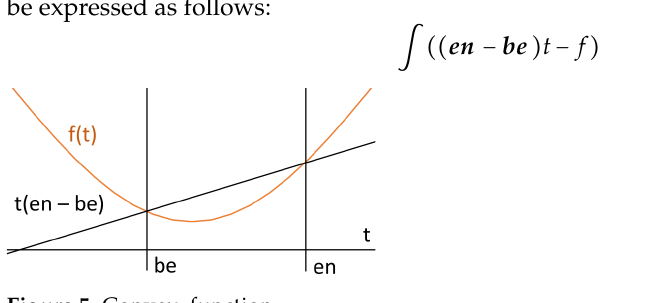
Figure 5. Convex